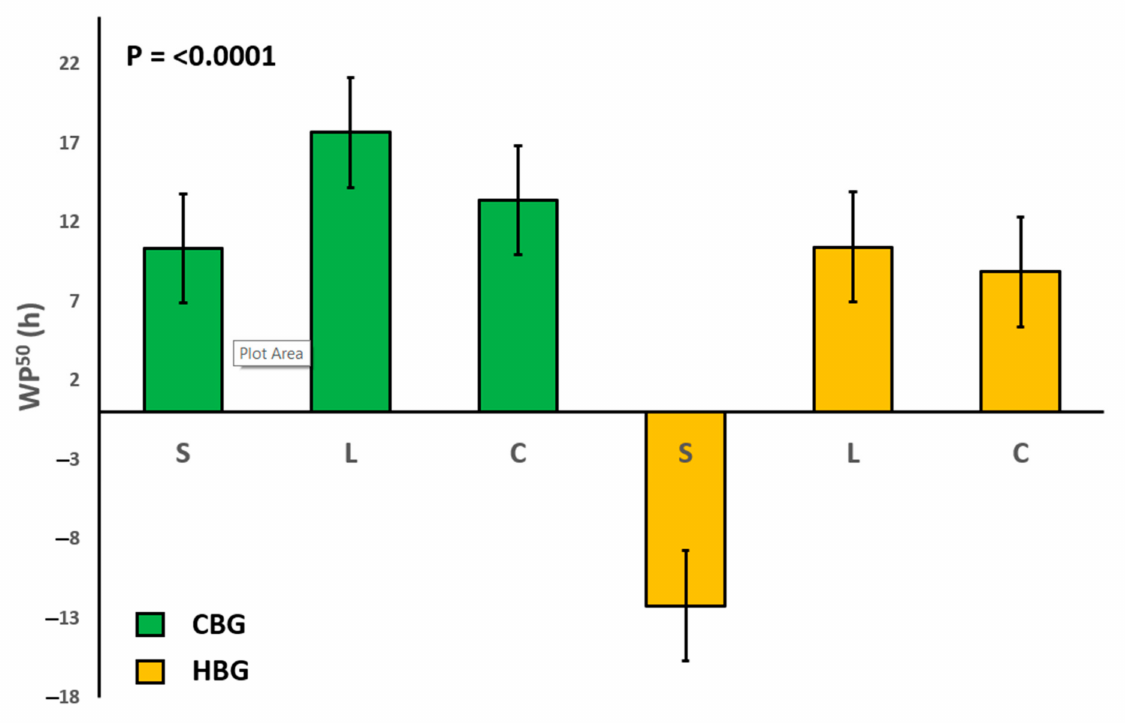
Figure 6. Values for 50% wilt prediction time (WP 50 ) after initiating six dry down cycles of six treatments with two grass species creeping bentgrass (CBG) and hybrid bermudagrass (HBG) grown on USGA 90:10 sand (S), loam (L), and clay (C) under greenhouse conditions in Blacksburg, VA. The WP 50 was calculated as the difference in time between the drought stress indication time and observed 50% wilt. Drought stress indication time values were generated using water band index (WBI)